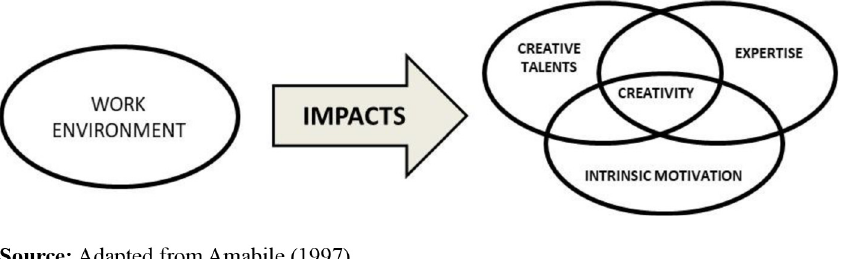
Figure 1. Components